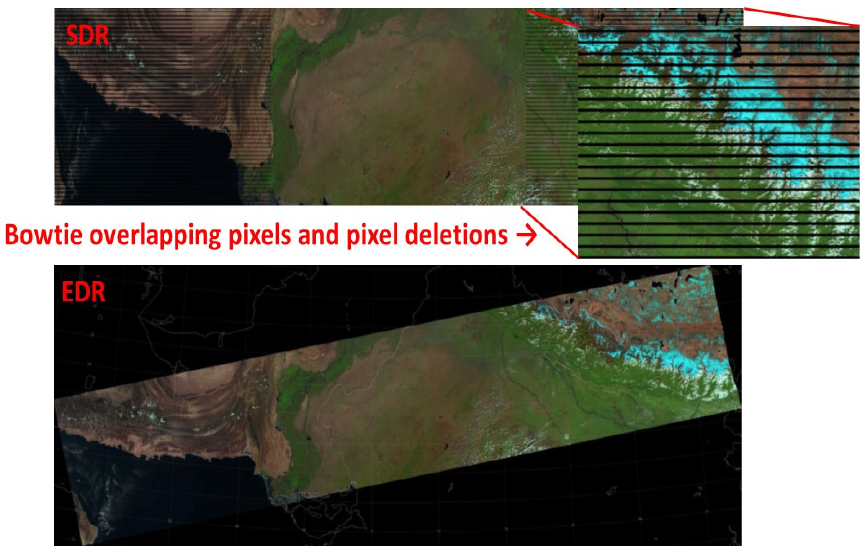
Figure 1. The difference between VIIRS SDR ( top ) and EDR ( bottom ) granules is the remapping into the GTM grid, which eliminates both the missing pixels (black lines at each end of the SDR granule) and also compensates for any remaining overlap in the SDR pixels.